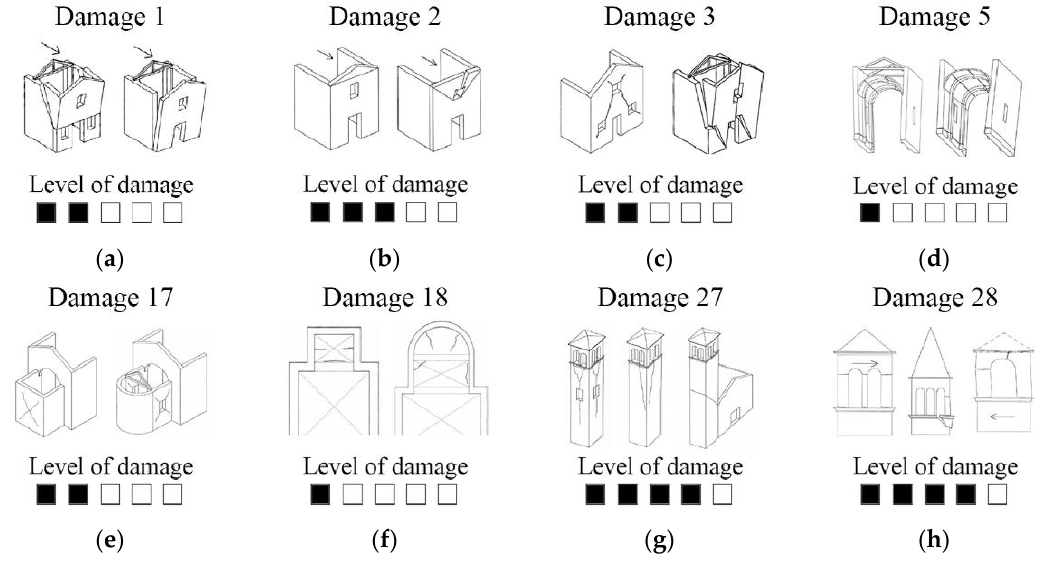
Figure 10. Activated mechanisms and level of damage. Source data: [52]. ( a ) Overturning of the façade; ( b ) mechanisms of the upper part of the façade; ( c ) in-plane mechanisms of the façade; ( d ) longitudinal response of the lateral wall, in plane; ( e ) shear mechanism of the aps; ( f ) vaults of the aps; ( g ) bell tower; ( h ) upper portion of the bell tower.